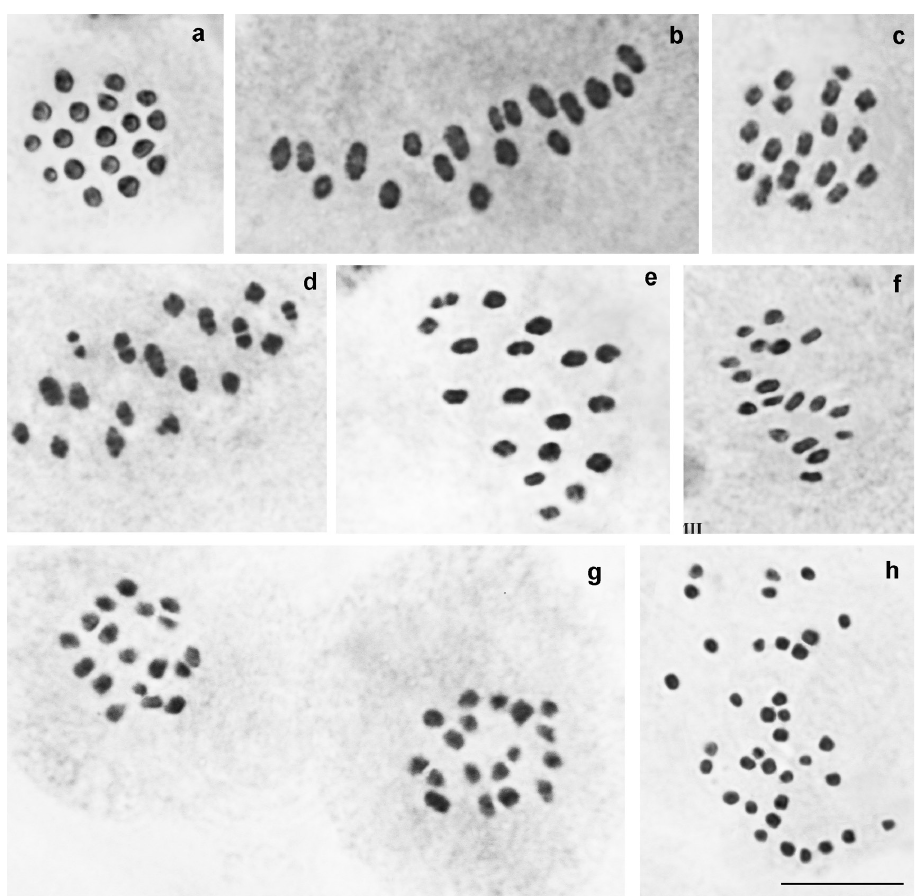
Figure 4. Karyotype of P. damonides from Iran (previously known as P. elbursicus ). a sample E234, MI, n=18 b sample E193, MI, n=18 c sample E460, MI, n=18 d sample E237, MI, n=18 e sample E459, MI, n=18 f sample E193, MII, n=18 g sample J573, two sister MII plates, n=18 h sample E234, male atypical meiosis, 2n=36. Bar = 10